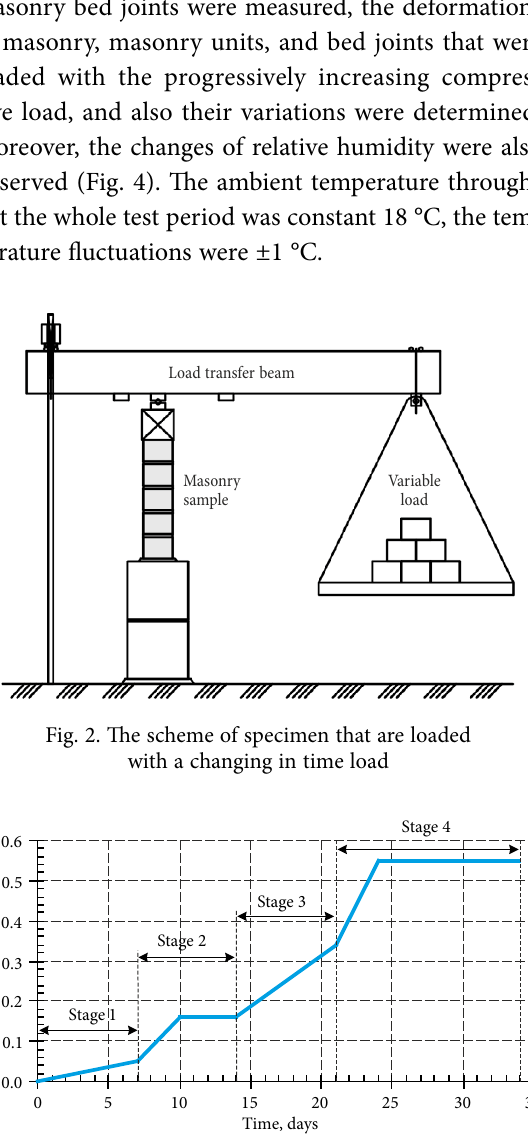
Fig. 3. The variation of s4tress at masonry wall with the increasing weight of built constructions